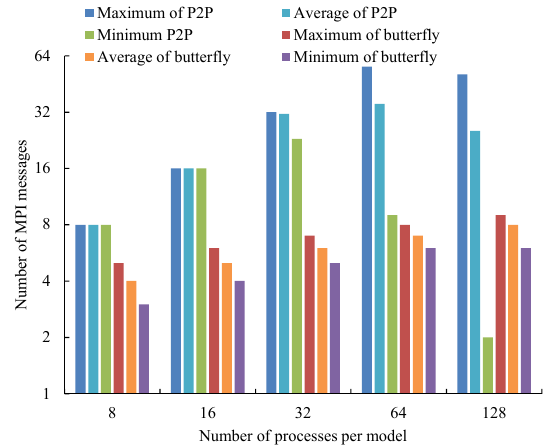
Figure 10. Maximum number of MPI messages, average number of MPI messages and minimum MPI messages in P2P implementation and butterfly implementation ( y axis), when varying the number of processes per model ( x axis) in GAMIL2–CLM3. The experimental set-up is similar to that shown in Fig.